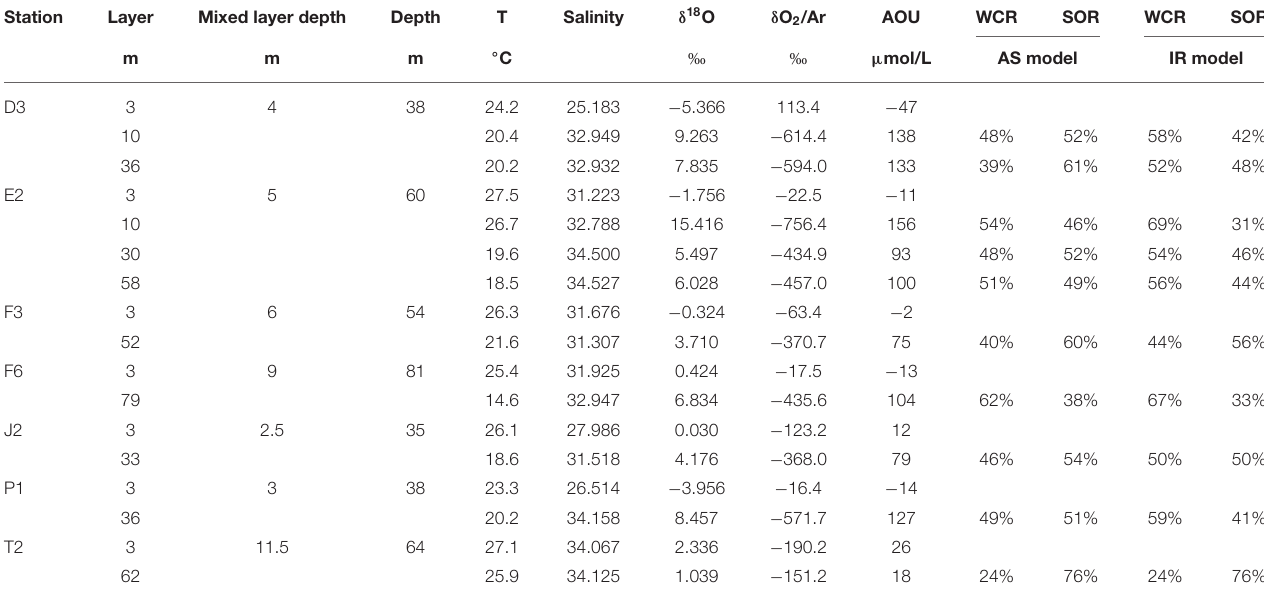
TABLE 1 | Temperature, salinity, and O 2 results, and estimated WCR% and SOR% in this study. Station Layer Mixed layer depth